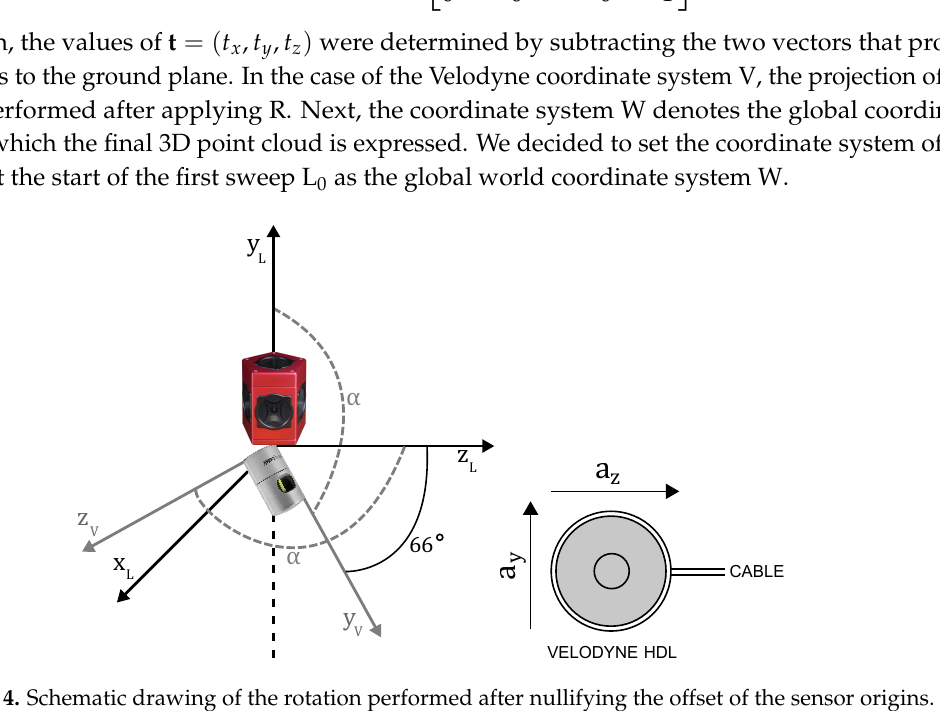
Figure 4. Schematic drawing of the rotation performed after nullifying the offset of the sensor origins. The angle about the x-axis, i.e., the pitch angle, was computed using the output of the two-axis accelerometer a = ( a y , a z ) from the Velodyne HDL. In this figure, the subscript L denotes the coordinate system of the Ladybug, whereas V denotes the coordinate system of the